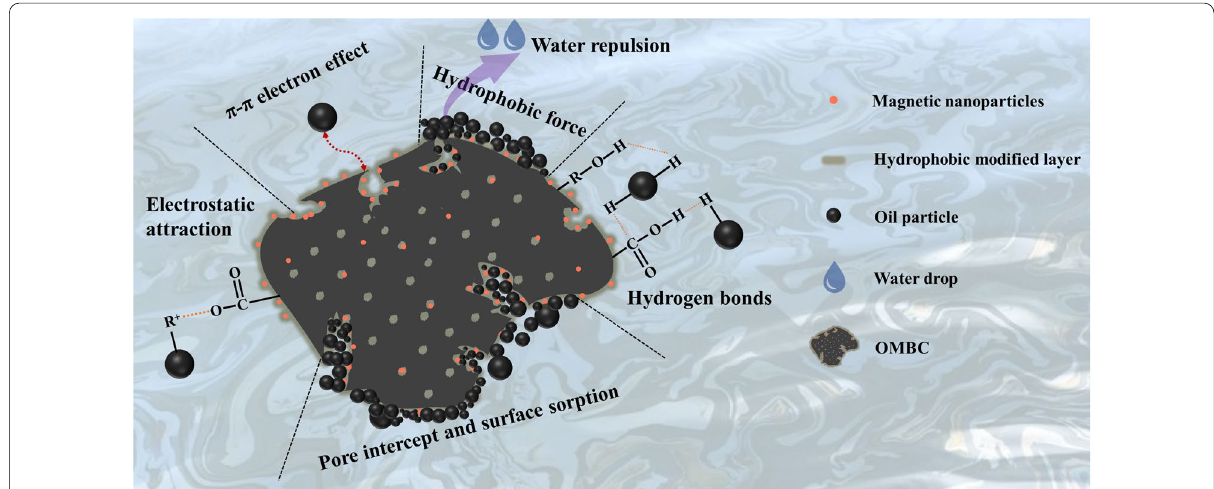
Fig. 10 The schematic diagram for sorption mechanisms of oil by